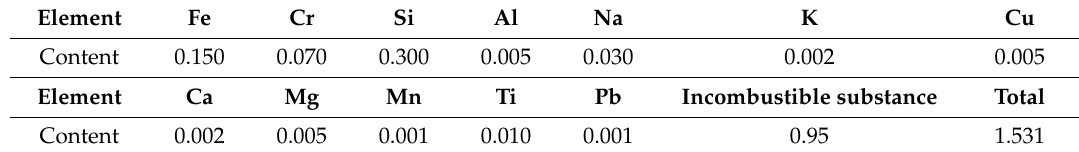
Table 2. Contents of impurity elements in ultra-dispersed nanodiamond powder (% by